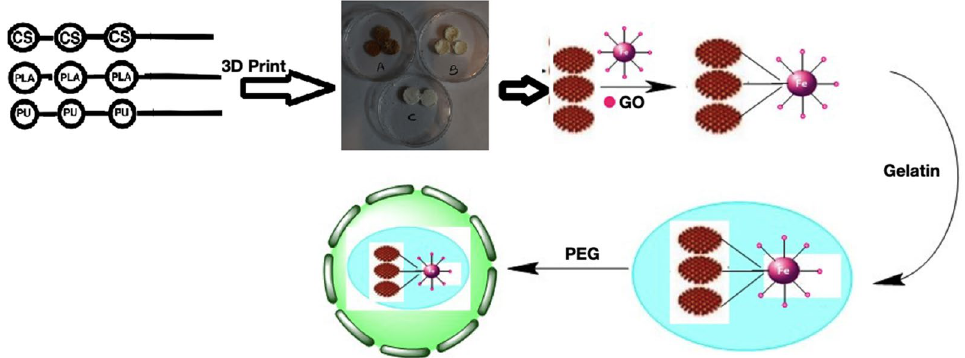
Figure 1. Process for modifying the surface of 3D print scaffolds [(Fe 3 O 4 @EOP/CS/PLA/PU-Mo-Ge) PEGylated] used in cardiovascular